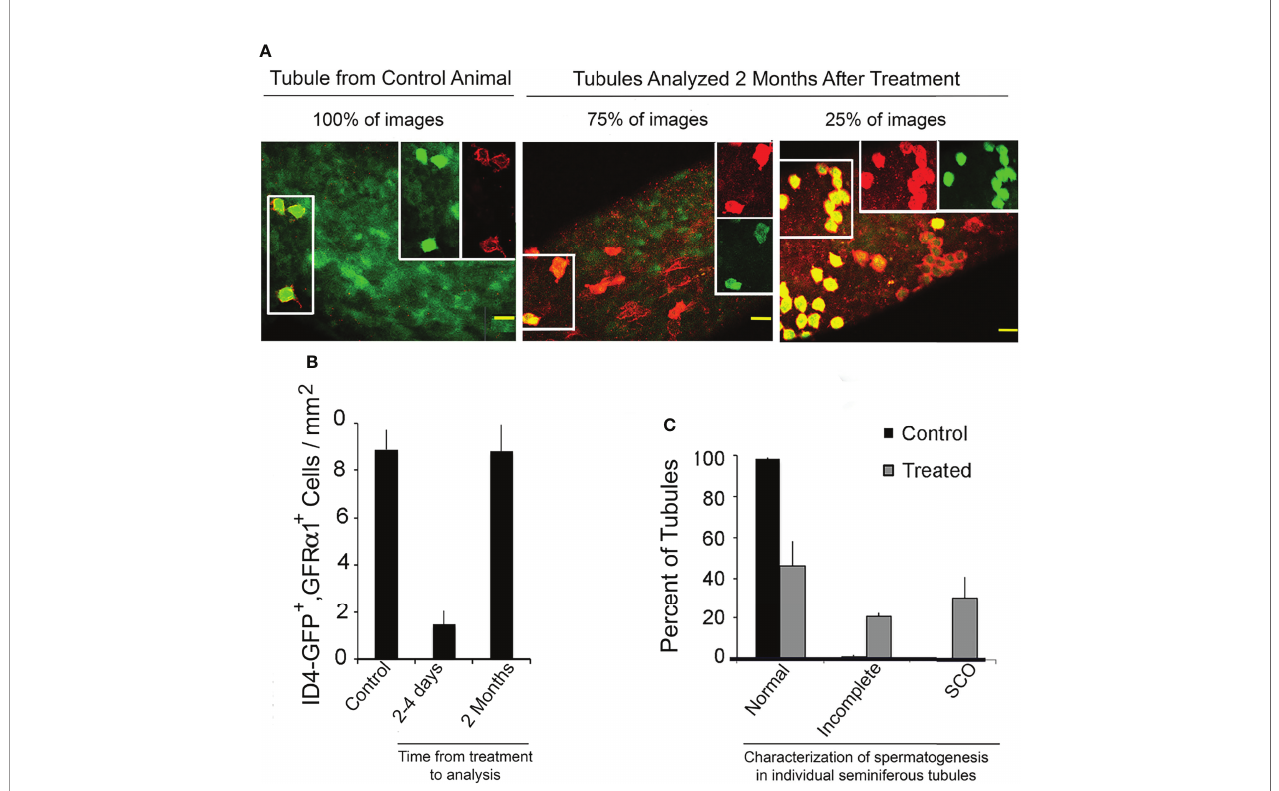
FIGURE 8 | A mouse SSCs pool that has been partially depleted due to inhibition of GDNF signaling will rebuild if GDNF signaling is restored. Mice used for this experiment were from the same liters that provided mice for enumeration of transplantable SSCs (See: Figure 2A ). Ret(V805), Rosa 26 +/- , ID4-GFP +/- mice were injected for 9 days with vehicle (control) or with 1NAPP1, tubules were collected 2 to 4 days or 2 months thereafter and GFR a 1-expressing cells detected by immunocytochemistry. Tubules were imaged by confocal microscopy and SSCs were de fi ned as co-expressing GFR a 1 (red fl uorescence) and ID4-GFP (green fl uorescence). Intact testes from additional control and treated mice (n = 3/group) were collect 2 months after the last injections and process for light microscopy as described for Figure 3 . Spermatogenesis in each tubule cross section was examined. (A) Confocal micrographs of tubules of control mice, and of tubules from mice sacri fi ced 2 months after treatment with 1NAPP1. Cells that expressed both GFR a 1 and GFP are outlined by a box on the left had side of each image. Separate red and green channels for the same cells are shown in the boxes on the right side. GFR a 1 + , ID4-GFP + cells were identi fi ed as A s spermatogonia in all images of tubules from control mice, in all images of tubules from mice sacri fi ced 2-4 days after treatment and in 75% of the images of tubules collected 2 months after treatment. In the other 25% of those images, GFR a 1 + , ID4-GFP + cells were present as chains or clusters of cells. (B) Numbers of GFR a 1 + , ID4-GFP + spermatogonia per mm 2 of tubule in control mice, in mice sacri fi ced 2-4 days after treatment and in mice sacri fi ced 2 months after treatment. Data are presented as mean + SEM for 5 control animals and for 3 mice at each of the two time points. (C) Characterization of spermatogenesis in seminiferous tubules of control mice and of mice sacri fi ced 2 months after treatment (n = 3/group). Tubules were characterized as having normal spermatogenesis, incomplete spermatogenesis (containing 2-4 generations of germ cells) or lacking all germ cells and thus exhibiting SCO syndrome. Normal or incomplete spermatogenesis was observed in 71% of tubules of treated mice. Taken together, these results demonstrate that when GDNF signaling is inhibited for 9 days and then restored, the depleted SSC pool is partially rebuilt. Results are from: